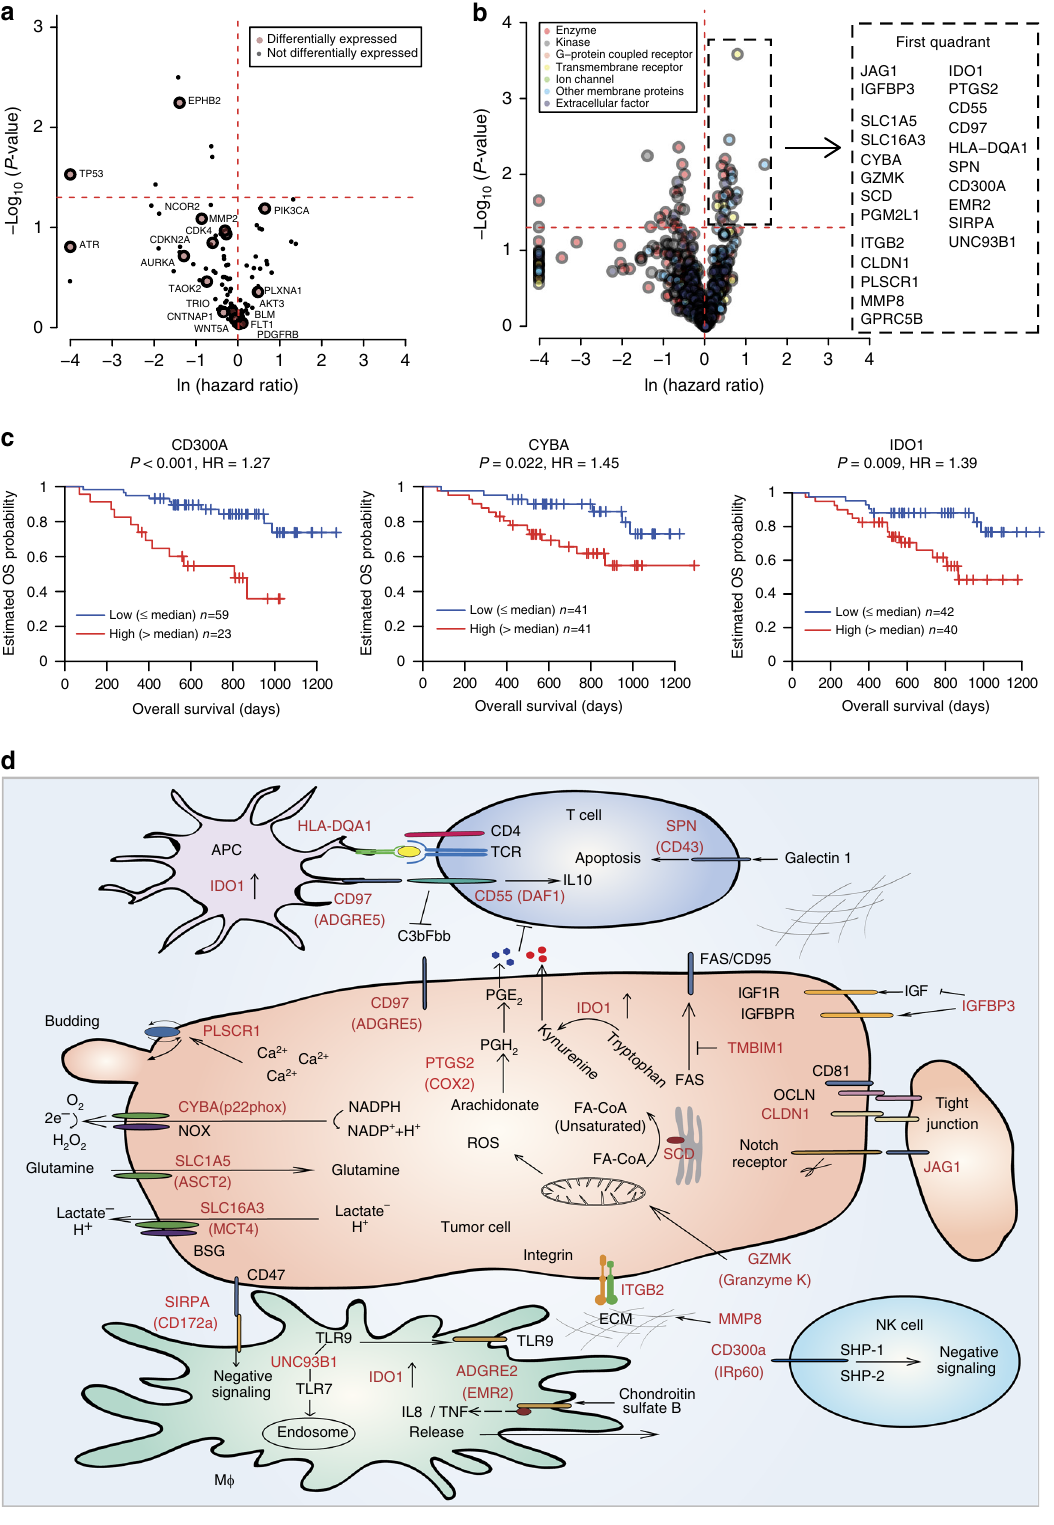
Fig. 5 Nominating potential druggable proteins for DGC. a The association between protein expression (T/N ratio) and overall survival of genomic data discovered drug targets. The ln (Hazard ratio) ( x -axis) and log 10 ( P -value) ( y -axis) were calculated from Cox proportional hazards regression analysis. Ln (Hazard ratio) > 4 or < − 4 were plotted with 4 or − 4. Large dots depict proteins overexpressed in tumors, and small dots depict proteins that are not overexpressed in tumors. b The association between protein expression (T/N ratio) and overall survival of proteomic data discovered drug targets. A list of 23 proteins overexpressed in tumors with log-rank P- value < 0.05 and ln (hazard ratio) > 0 is included in the box on the right. c The association between protein expression of CD300A, CYBA and IDO1 and overall survival (Kaplan – Meier analysis, P- value from log-rank test, high means T/N > median value). d Cellular localization and signaling pathways of nominated drug target candidates. The nominated druggable protein candidates are depicted in